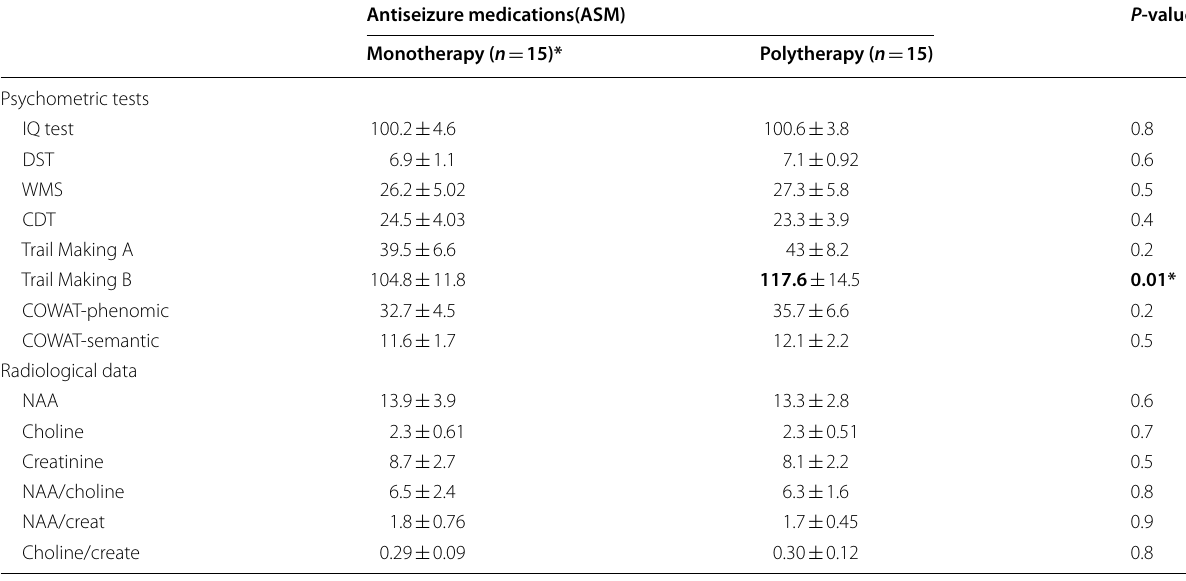
Bold indicates * p < 0.05 is considered